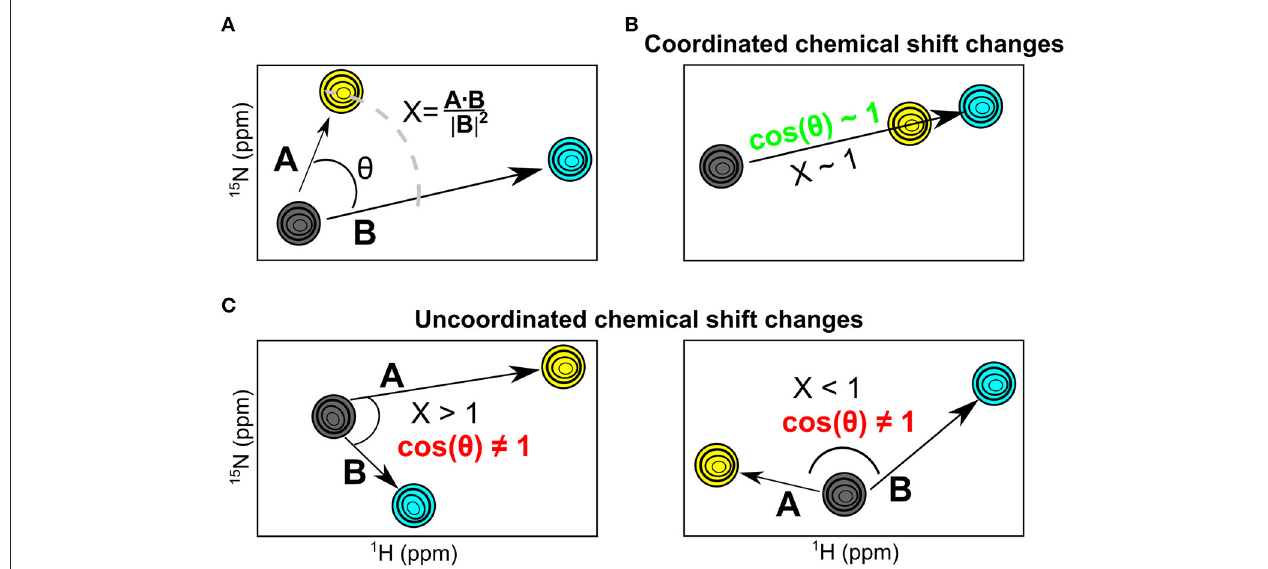
FIGURE 4 | The NMR chemical shift projection analysis (CHESPA). (A) Schematic representation of the CHESPA analysis showing 1 H- 15 N HSQC chemical shift resonances of the apo (gray), 3 ′ -UMP (yellow) and 5 ′ -AMP (cyan) states. Vectors A, B correspond to the compounded chemical shifts calculated for 3 ′ -UMP-bound and 5 ′ -AMP-bound complexes relative to the apo state. The two projection analysis parameters, projection angle and fractional shift, were calculated as described in the section Methods. (B,C) Graphical representation of scenarios representing coordinated (B) and uncoordinated displacements (C) of the 1 H- 15 N HSQC chemical shifts upon ligand